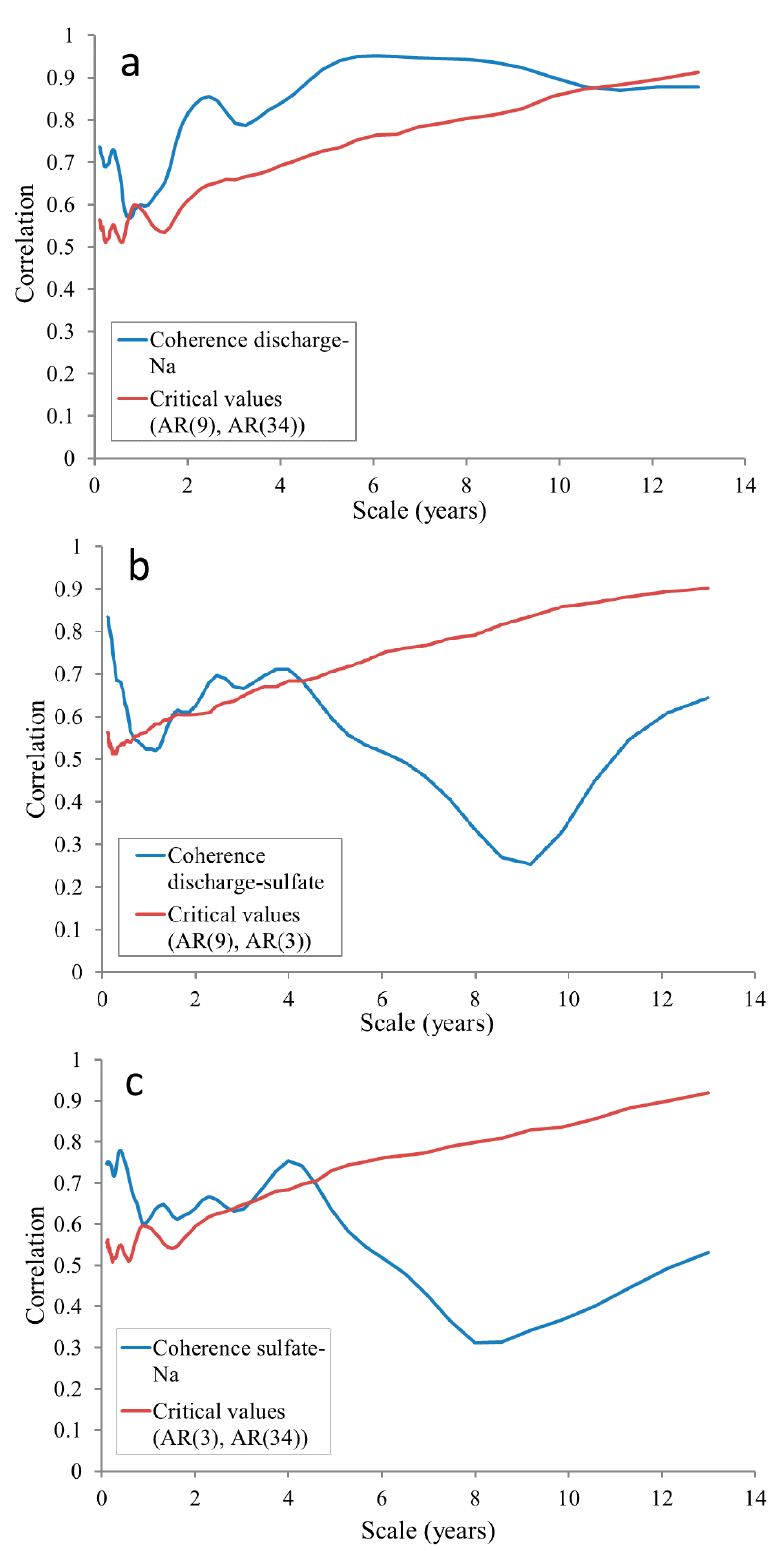
Figure 5. Global coherences and wavelet coherence spectra (WCSs) for ( a ) discharge-sodium, ( b ) discharge-sulfate, and ( c ) sulfate-sodium. y-axes represent coherences (between 0 and 1) and x-axes scales (in years).